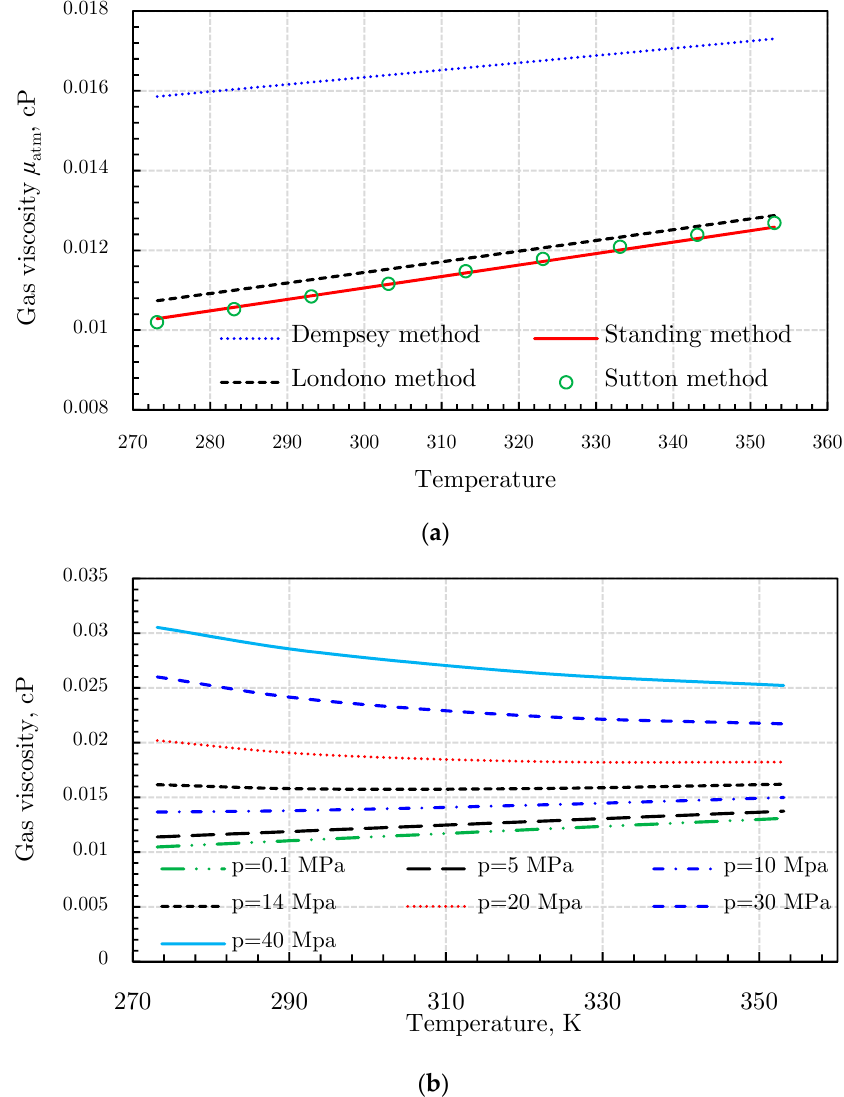
Figure 28. Gas viscosity variance with temperature at di ff erent pressure conditions. ( a ) Gas viscosity calculated from di ff erent methods at atmospheric pressure. ( b ) Gas viscosity calculated from the Standing method at di ff erent pressures.